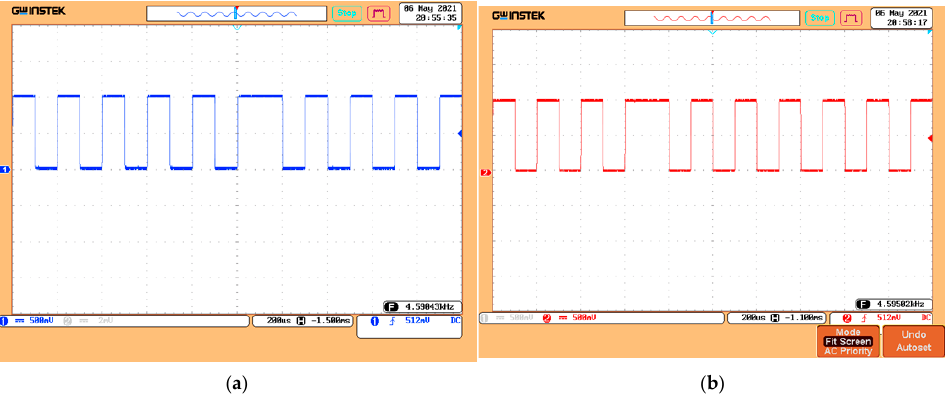
Figure 25. Inverter control pulses of the stator ( a ) and rotor ( b ) of the GA–DTC.